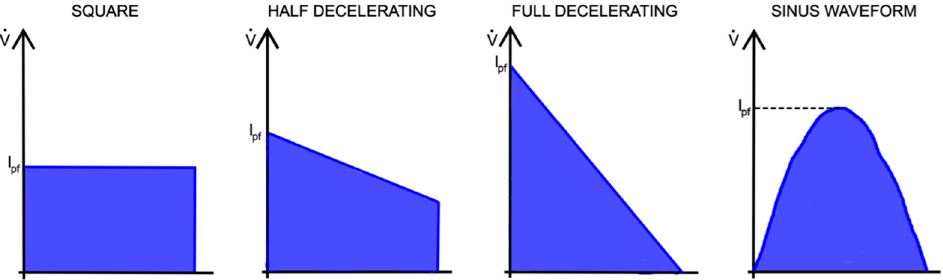
Figure 5. Various flow patterns typically used in VC − CMV mode.